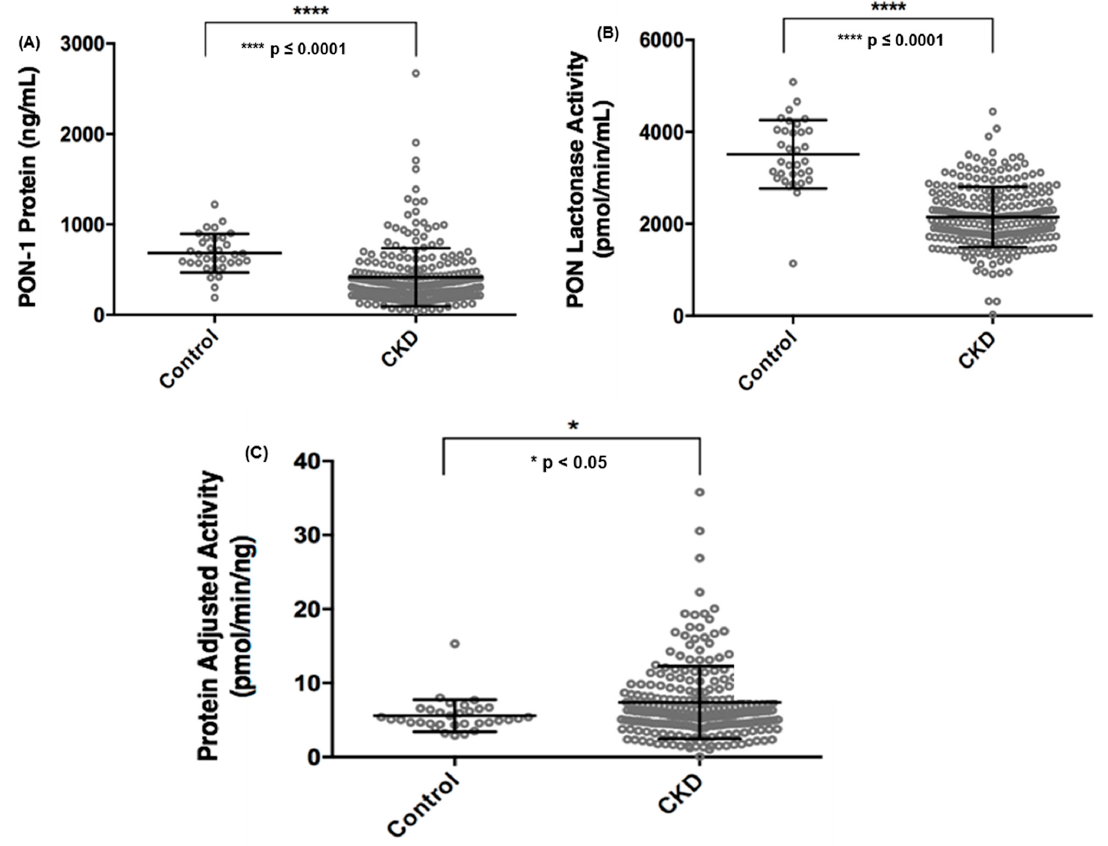
Figure 1. Comparison of circulating paraoxonases ‐ 1 (PON ‐ 1) protein ( A ), PON lactonase activity ( B ), and PON protein adjusted lactonase activity ( C ) between non-chronic kidney disease (CKD) control and PON protein adjusted lactonase activity ( C ) between non ‐ chronic kidney disease (CKD) control subjects and patients with subjects and patients with CKD.